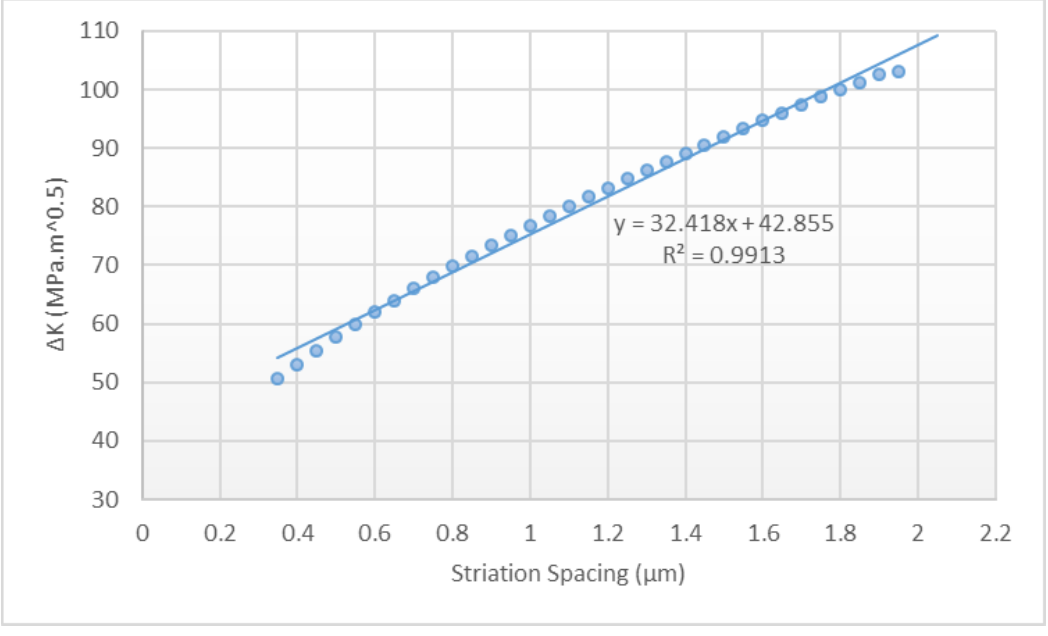
Figure A14. Counting the average striation spacing on the surface of the CS1 screw shows that the crack propagated from the bottom left to the top right.